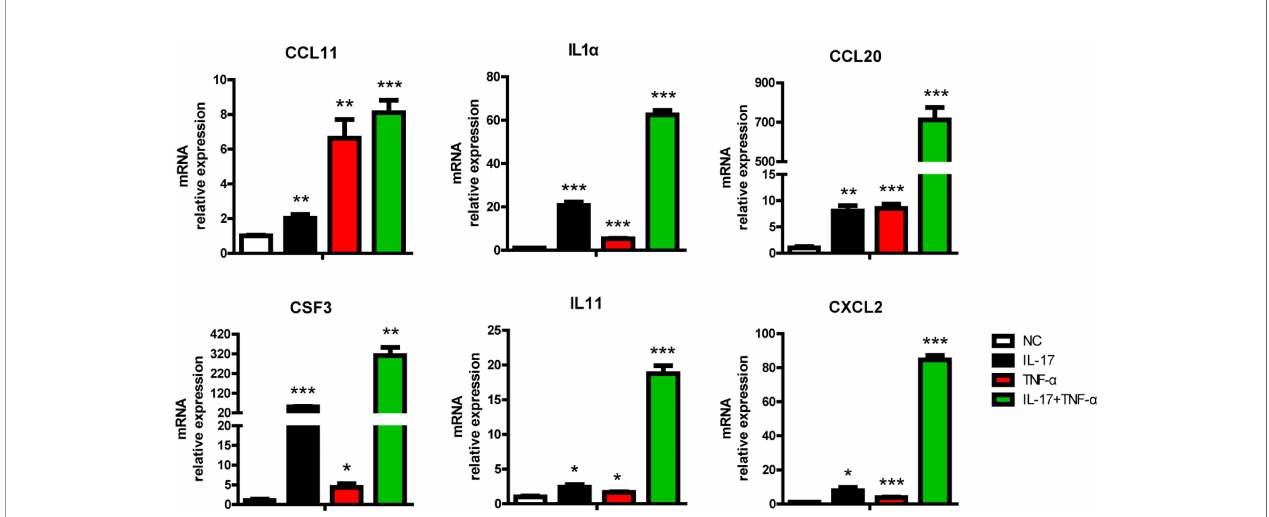
FIGURE 2 | IL-17 and TNF- a additively or synergistically induced chemokine or cytokine expression in porcine aortic endothelial cells (PAECs). PAECs were treated with rhIL-17 (100 ng/ml), rhTNF- a (2 ng/ml), or rhIL-17 plus rhTNF- a for 0 or 6 h. The induction of CCL11, IL1 a , CCL20, CSF3, IL11, and CXCL2 mRNA was measured via real-time PCR. Data are representative of at least three independent experiments (mean ± SEM). * p < 0.05, ** p < 0.01, *** p < 0.001, determined by Student ’ s t